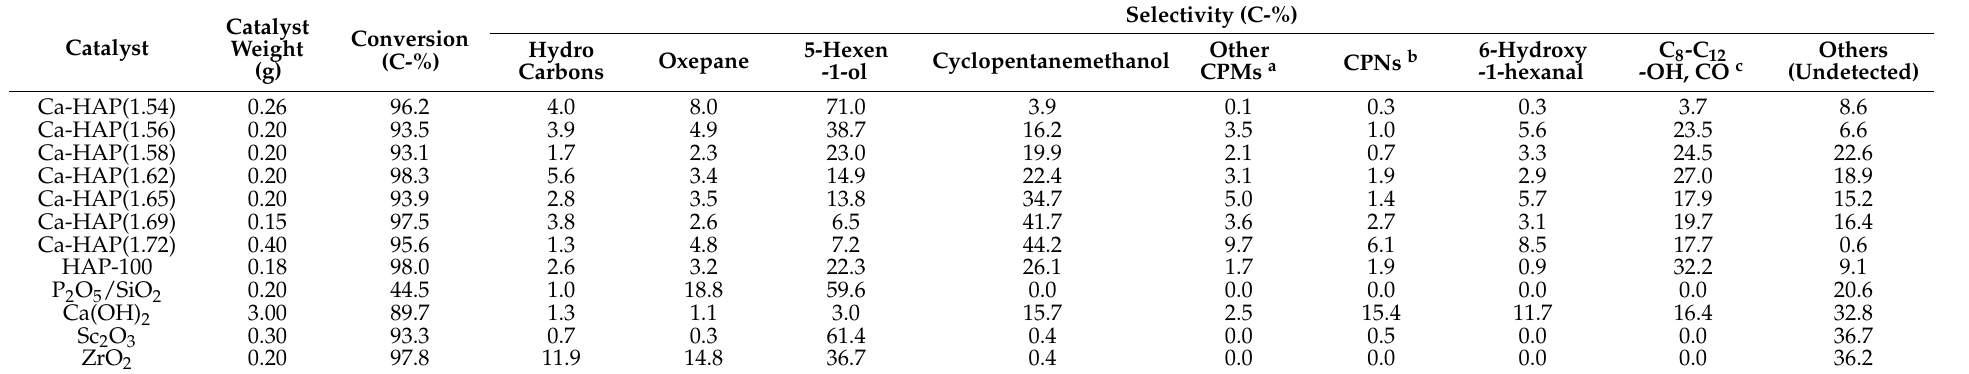
Table 5. 1,6-hexanediol conversion over various